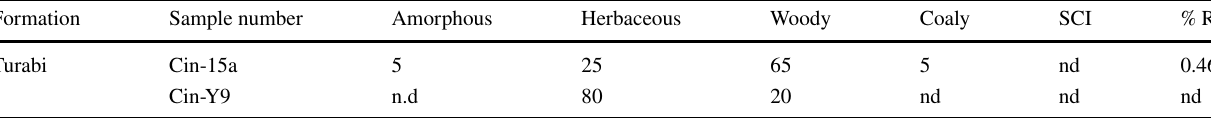
Fig. 7 The distribution of the Halıkışlak, Turabi and Tuzluca shale samples on S2 vs. TOC